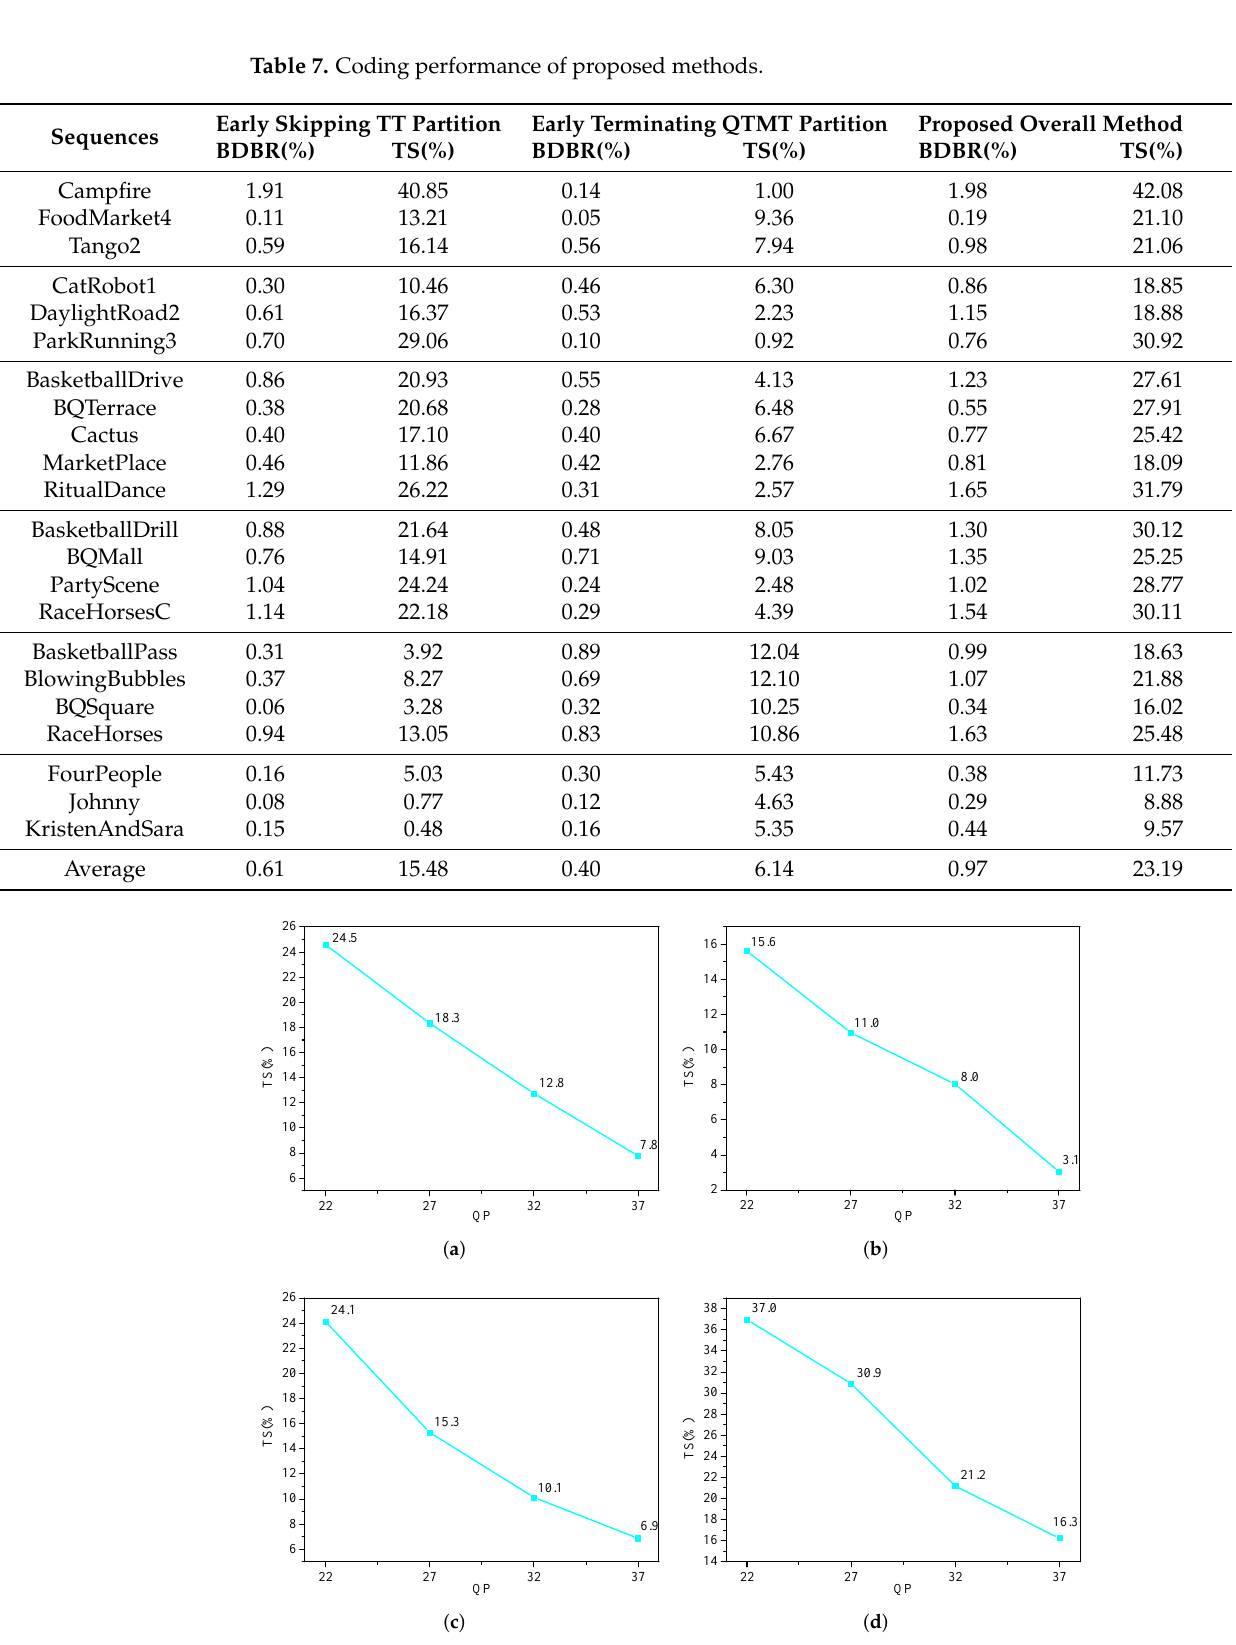
Figure 5. Encoding time saving under different QPs. ( a ) BasketballPass, ( b ) FourPeople, ( c ) Market- Place, and ( d )